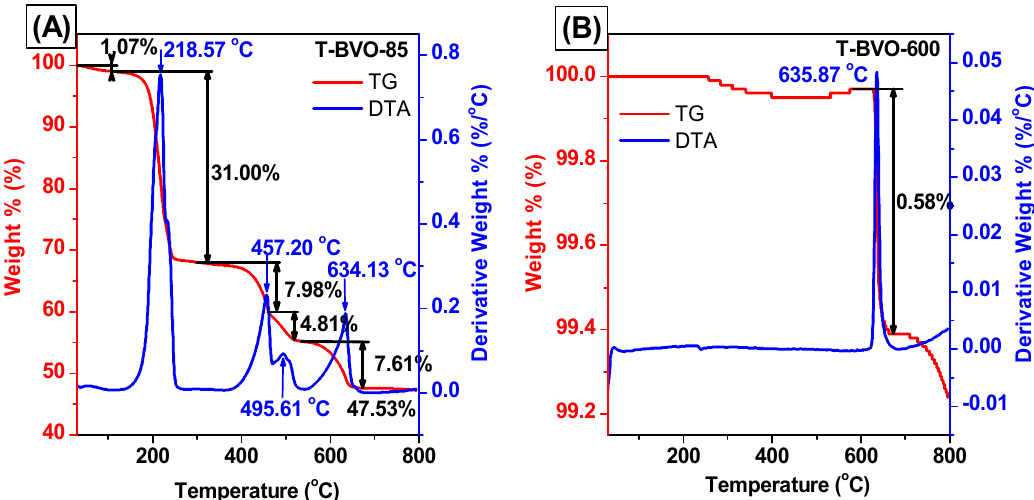
Figure 7. Di ff erential thermal analysis-Thermal gravimetric analysis (DTA-TGA) curves of the BiVO 4 : Figure 7. Differential thermal analysis - Thermal gravimetric analysis (DTA-TGA) curves of the BiVO 4 : ( A ) T-BVO-85 and ( B ) ( A ) T-BVO-85 and ( B ) T-BVO-600.